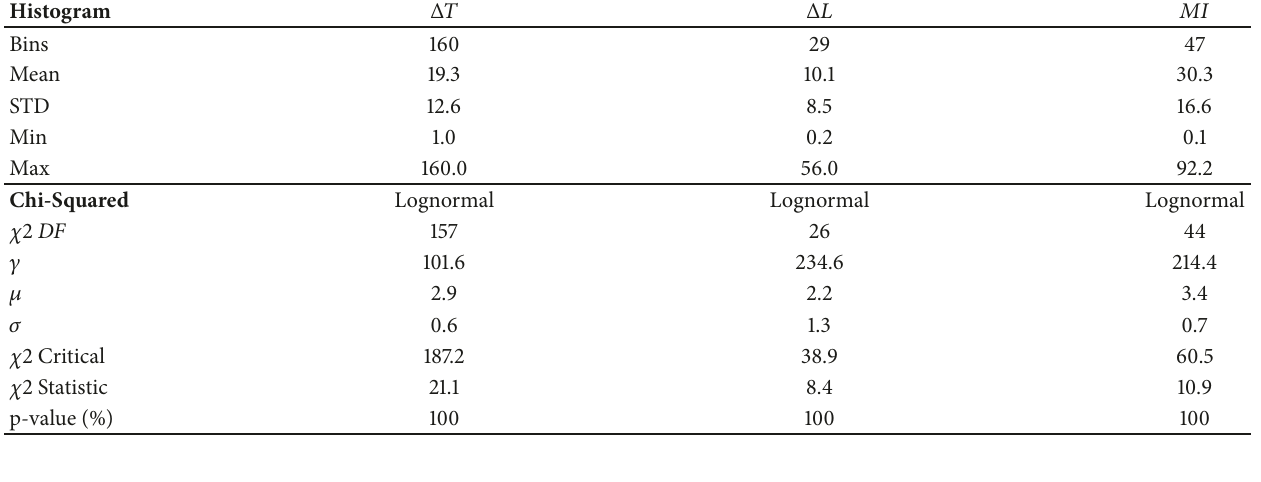
Table 2: Parameters of the cleaned distributions.